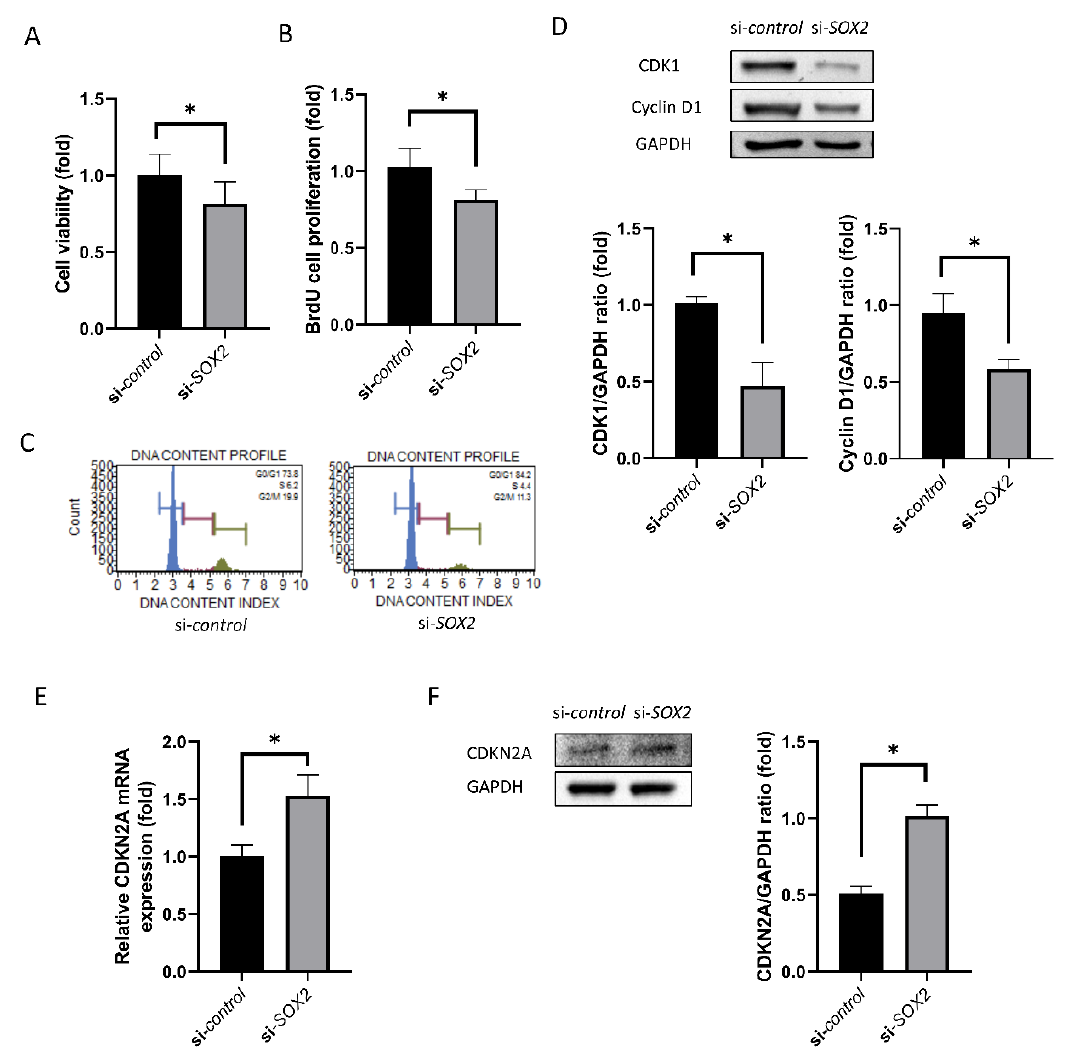
Figure 3. Cell viability and proliferation. ( A ) Cell viability. ( B ) BrdU cell proliferation rate. ( C ) Cell cycle analysis. ( D ) CDK1 and cyclin D1 levels. ( E ) CDKN2A mRNA expression evaluated by RT-PCR. ( F ) CDKN2A level evaluated by Western blotting was higher in si -SOX2 -transfected cells. Graph provides the results from triple experiments. * indicates statistical significance by independent t -test.